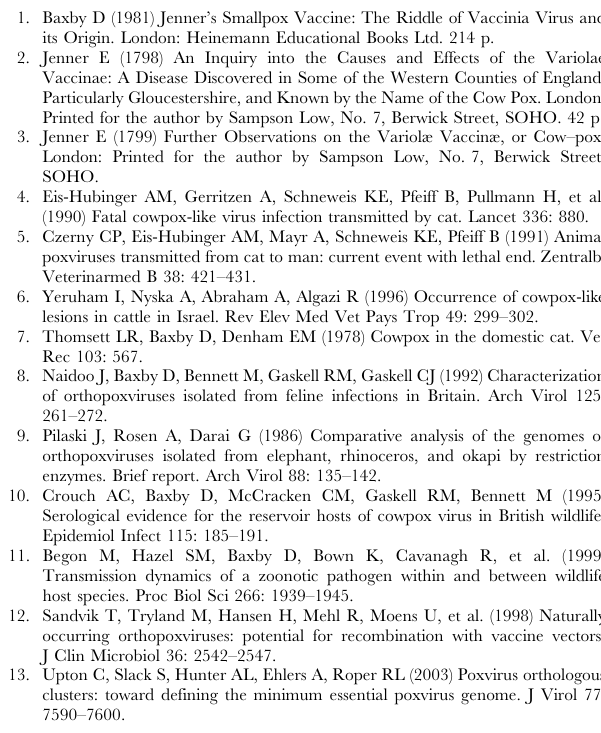
Figure S1 Image of twelve CPXV genomes created in Geneious Pro TM 5.3. The alignment was created using the MAFFT plugin. Orange arrows indicate coding regions in both directions. Bases are numbered at the top of the alignment and strain names indicated to the left. The reference genome, CPXV_GER1980 _EP4, is highlighted in yellow. In subsequent genomes, grey indicates identity and vertical black lines represent differences with respect to the reference sequence.